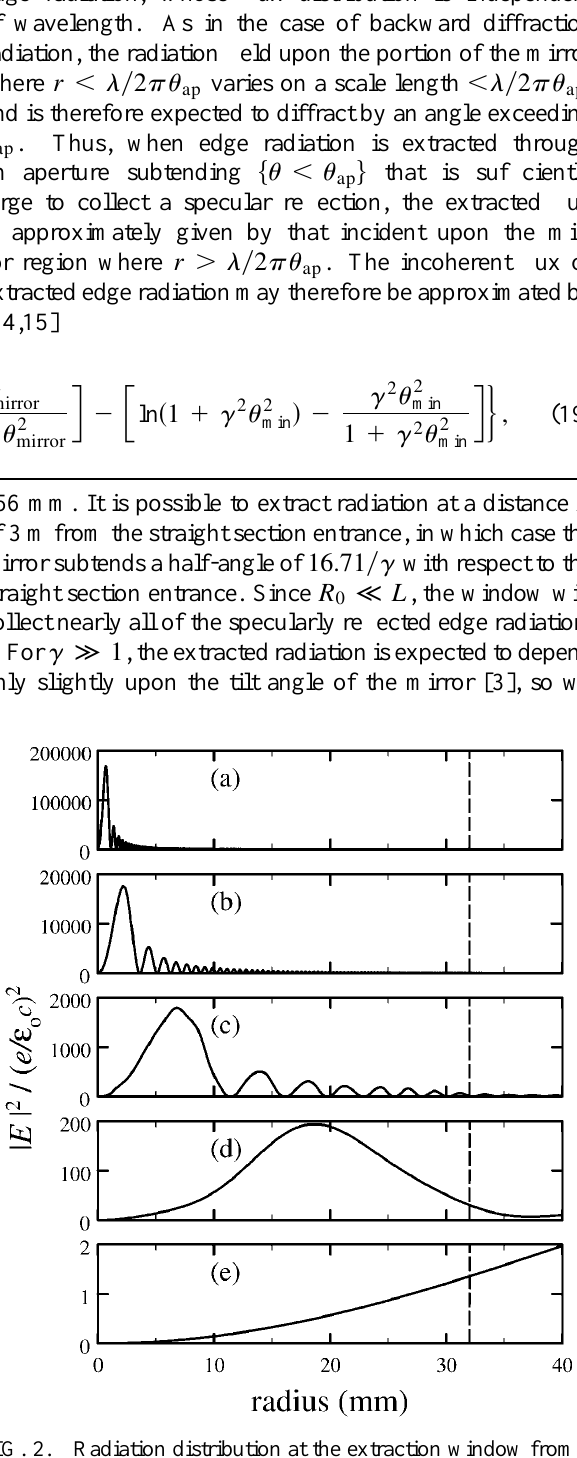
FIG. 1. Geometry for extraction of edge radiation within an Aladdin straight section, where L (cid:1) 3 m, a (cid:1) 9.5 mm, and b (cid:1) 32 mm. Values of R 0 that are considered are 32, 64, 128, and 256 mm.